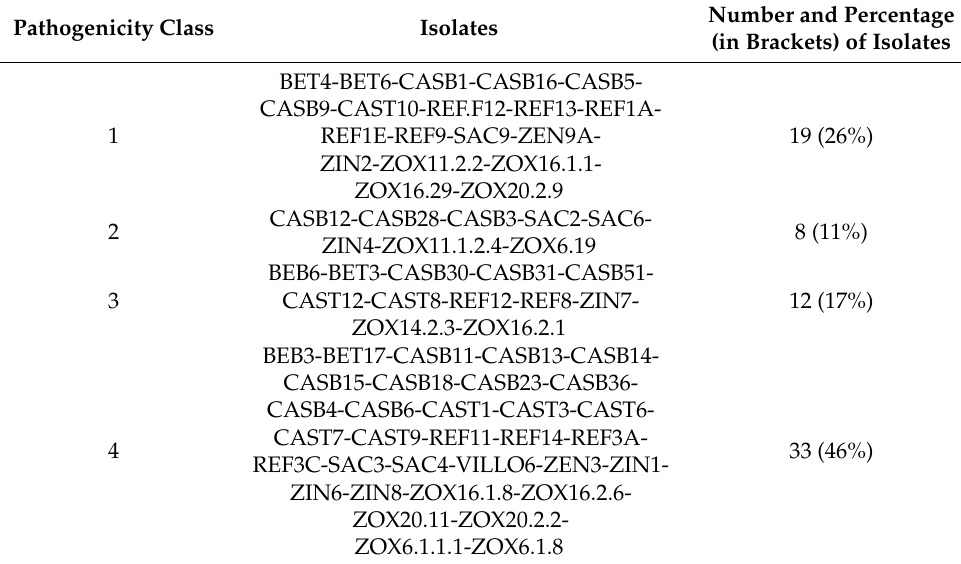
Table 4. Pathogenicity classes * assigned to the